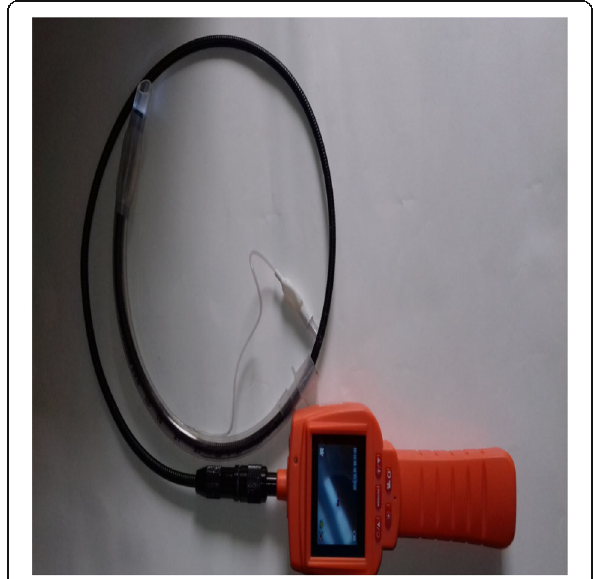
Fig. 2 Photograph for semi-flexible cold fibre optic probe fitted to the endotracheal tube and attached to portable video